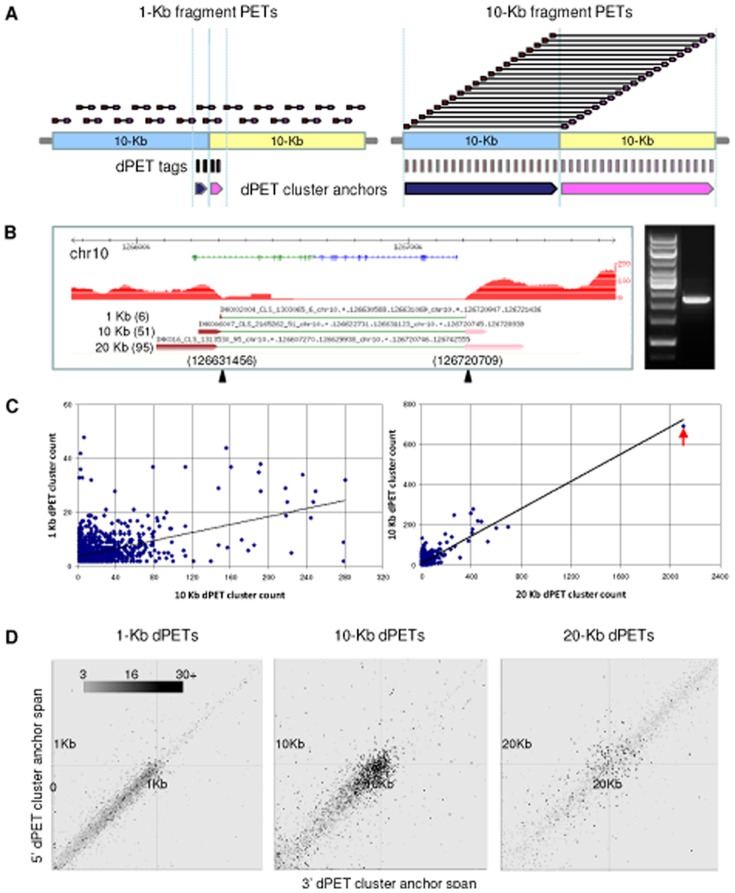
dPET cluster characteristics.(A) PET mapping overlap scheme based on the same number of PETs. 10 kb library dPETs have a higher chance than 1 kb library dPETs to cross the same breakpoints. (B) One common deletion identified in K562 by 1 kb, 10 kb and 20 kb libraries. Red track represents the coverage of the cPETs. The dPET cluster count in each library was 6, 51 and 95, respectively. The genomic PCR and Sanger sequencing confirmed the presence of the deletion and located the breakpoint positions to chr10:126,631,456 and chr10:126,720,709 (hg18). The differences between breakpoint position predicted by DNA-PET and PCR were 387 bp and 238 bp for the 1 kb library; 333 bp and 36 bp for the 10 kb library, and 482 bp and 37 bp in 20 kb library. (C) Cluster count correlation of the same set of SVs identified by both 1 kb and 10 kb libraries in the three genomes (left panel), and 10 kb and 20 kb libraries in K562 (right panel). The black line represents the trendline. The rearrangement between chromosomes 9 and 22 creating the CML causing BCR-ABL1 fusion gene [23] was identified by the largest clusters of 692 dPETs in the 10 kb library and 2,106 dPETs in the 20 kb library (red arrow head). (D) Length distribution of 5′ and 3′ anchor regions (regions in which the tags of dPET clusters are mapping) in 1 kb, 10 kb and 20 kb libraries of K562. The 10 kb library showed a more even length distribution of 5′ and 3′ anchor regions which suggested more balanced mapping characteristics around breakpoints for 10 kb libraries.